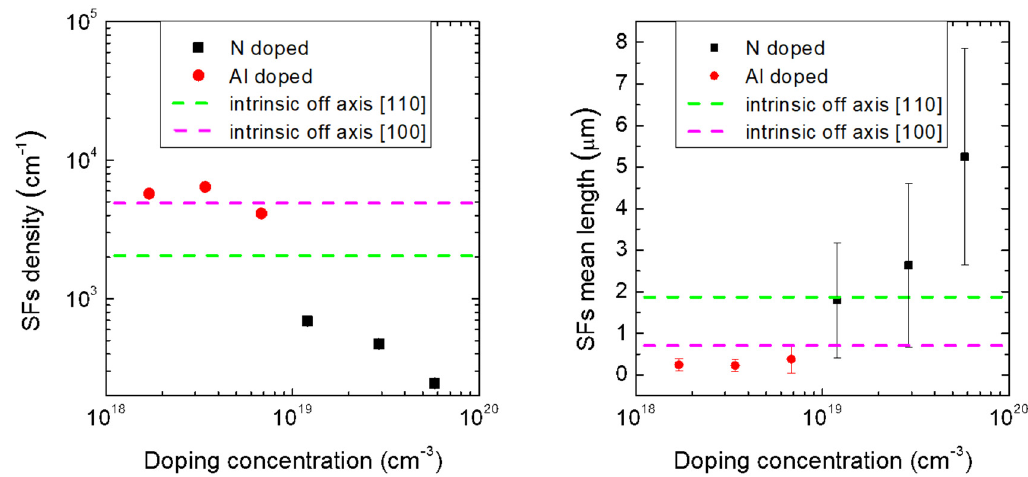
Figure 6. Distribution of SF density ( left panel ) and SF mean length ( right panel ) vs. doping concentration. The graphs also report the average density and average length of the intrinsic samples grown on Si (100) off-axis [110] (dashed green line) and off-axis [100] (dashed magenta line).